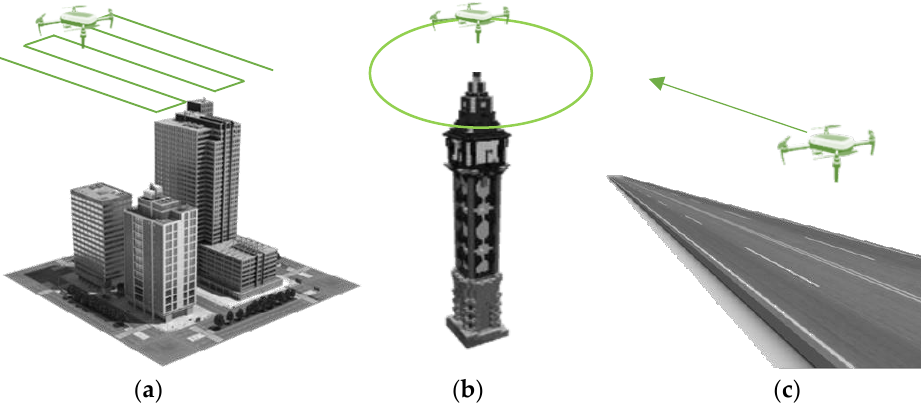
Figure 4 . Different types of drone flight missions. ( a ) Grid type. ( b ) Circular type. ( c ) Linear type.